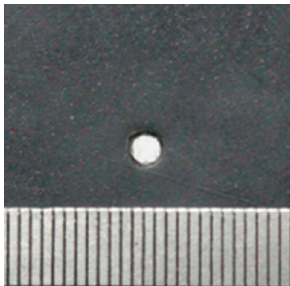
Figure 1. A photograph of prefabricated coating damage points drilled only through the coating (The scale is 1 mm).